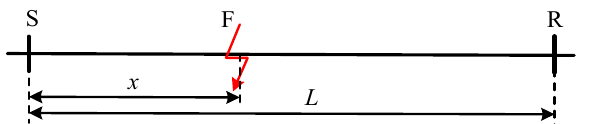
Figure 2. Uniform line fault